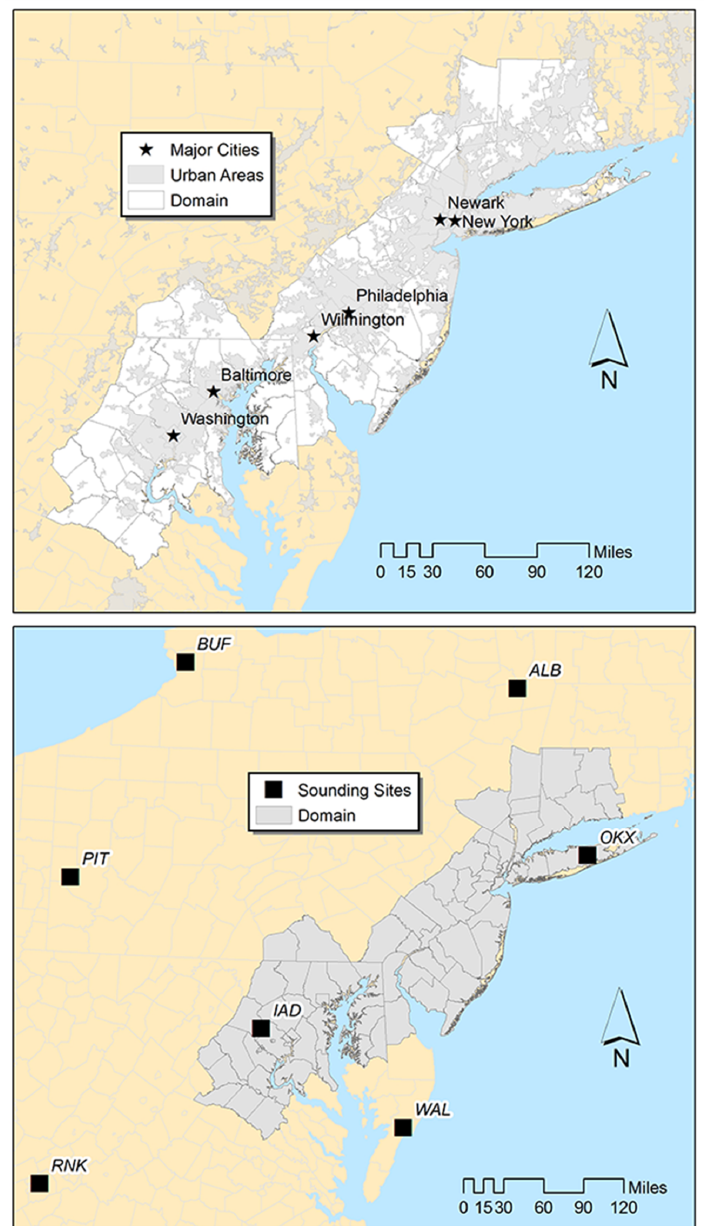
Figure 1. ( top ) The domain of study, major cities, and regional urban footprint. ( bottom ) NOAA- operated atmospheric sounding sites over the Mid-Atlantic region in the United States.